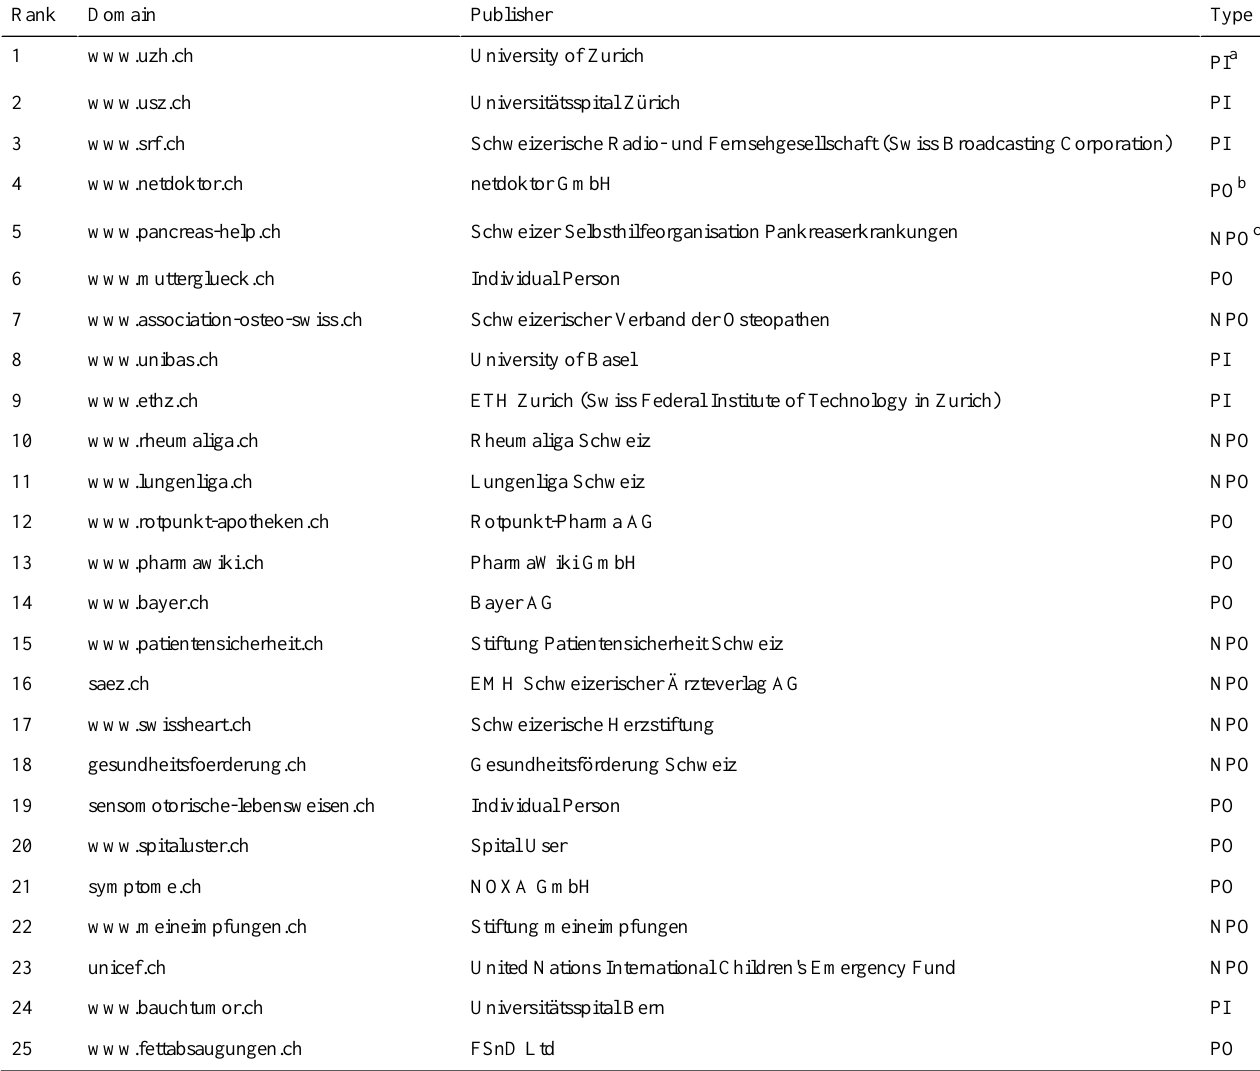
Table 6. Domains of 25 top-ranked web sites for country-code top-level domain .ch with their respective publisher according to